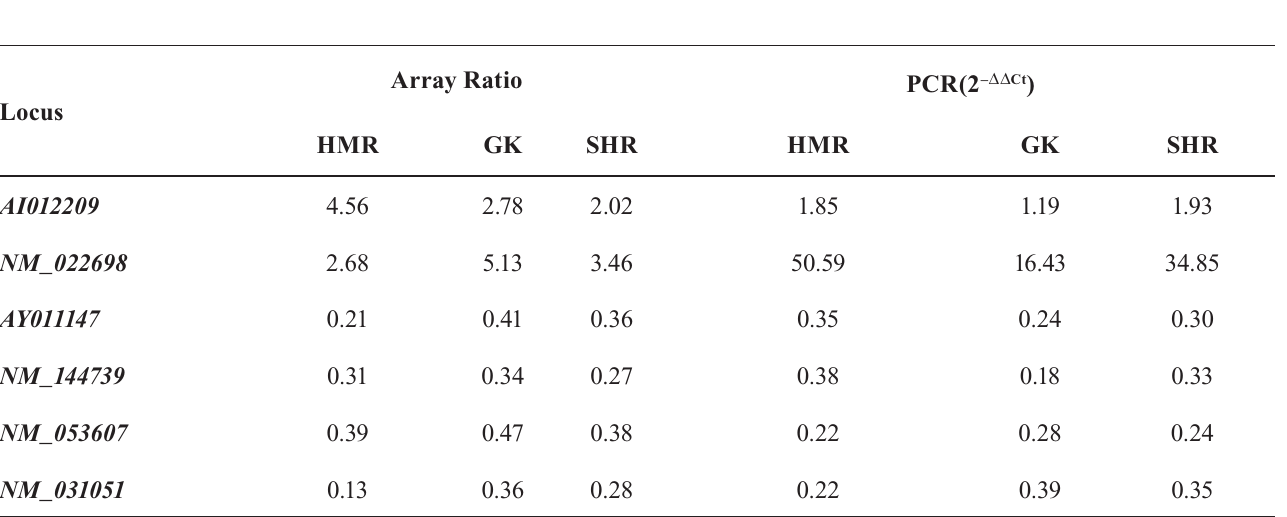
TABLE IV - Real-time PCR confirmation of array results